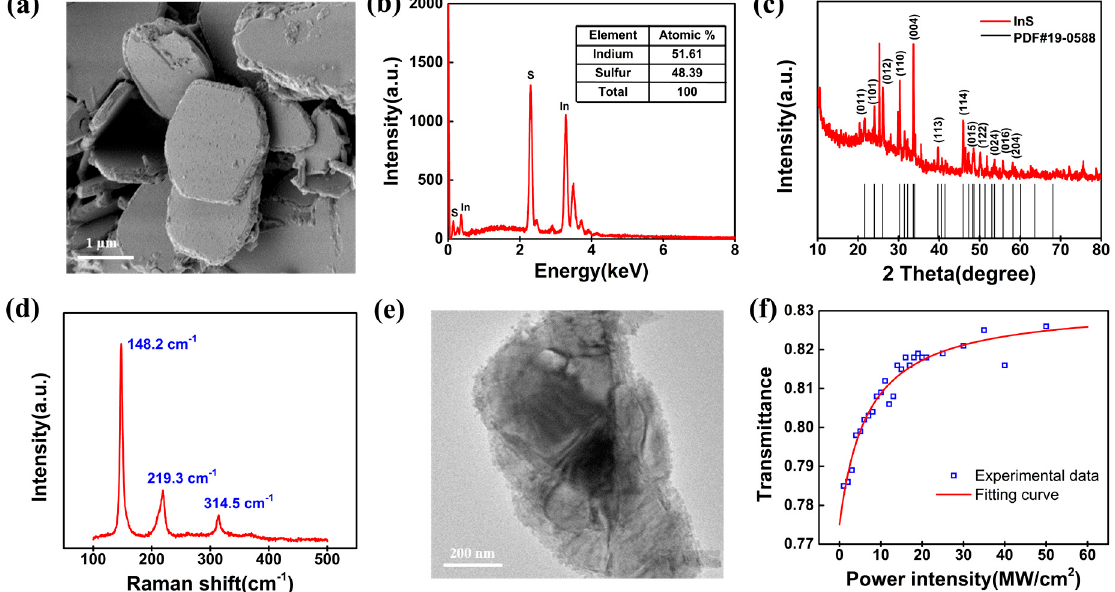
Figure 2. Characteristics of InS crystals: ( a ) A scanning electron microscopy (SEM) image of typical InS flakes; ( b ) energy-dispersive X-ray (EDX) spectroscopy image of the InS; ( c ) X-ray diffraction (XRD) pattern of the InS sample; ( d ) Raman spectroscopy image of the InS; ( e ) a representative transmission electron microscopy (TEM) image of an InS nanosheet after liquid-phase exfoliation; and ( f ) nonlinear transmission of the InS thin film under different incident power intensity.